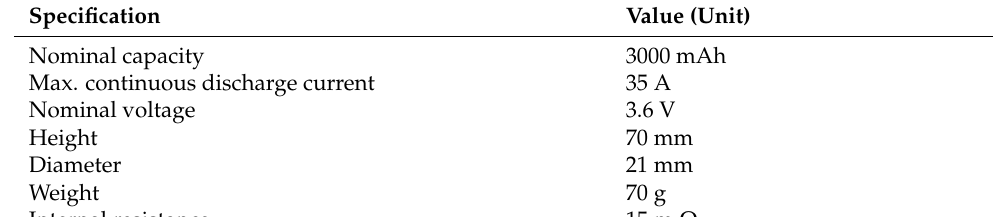
Table 2. Specifications of Li-ion battery.